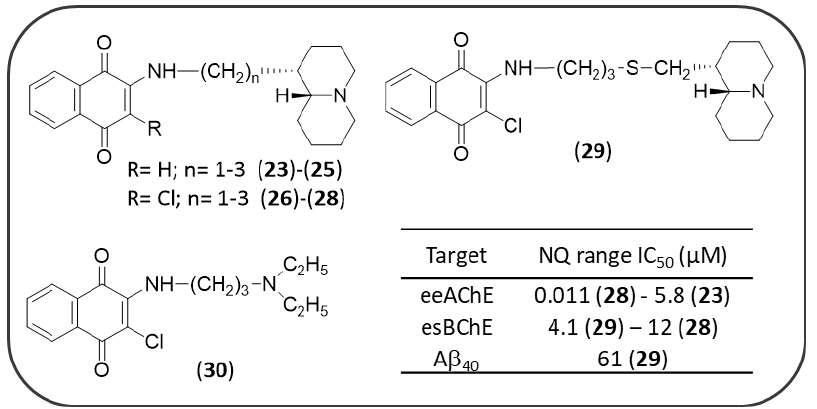
Figure 8. NQ derivatives studied by Sparatore et al. as ChEs and Aβ aggregation inhibitors.